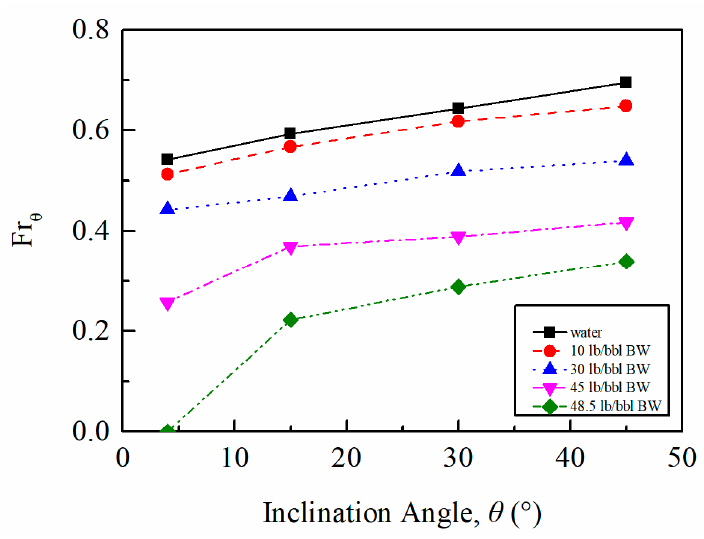
Figure 9. Drift velocity as a function of inclination angle.